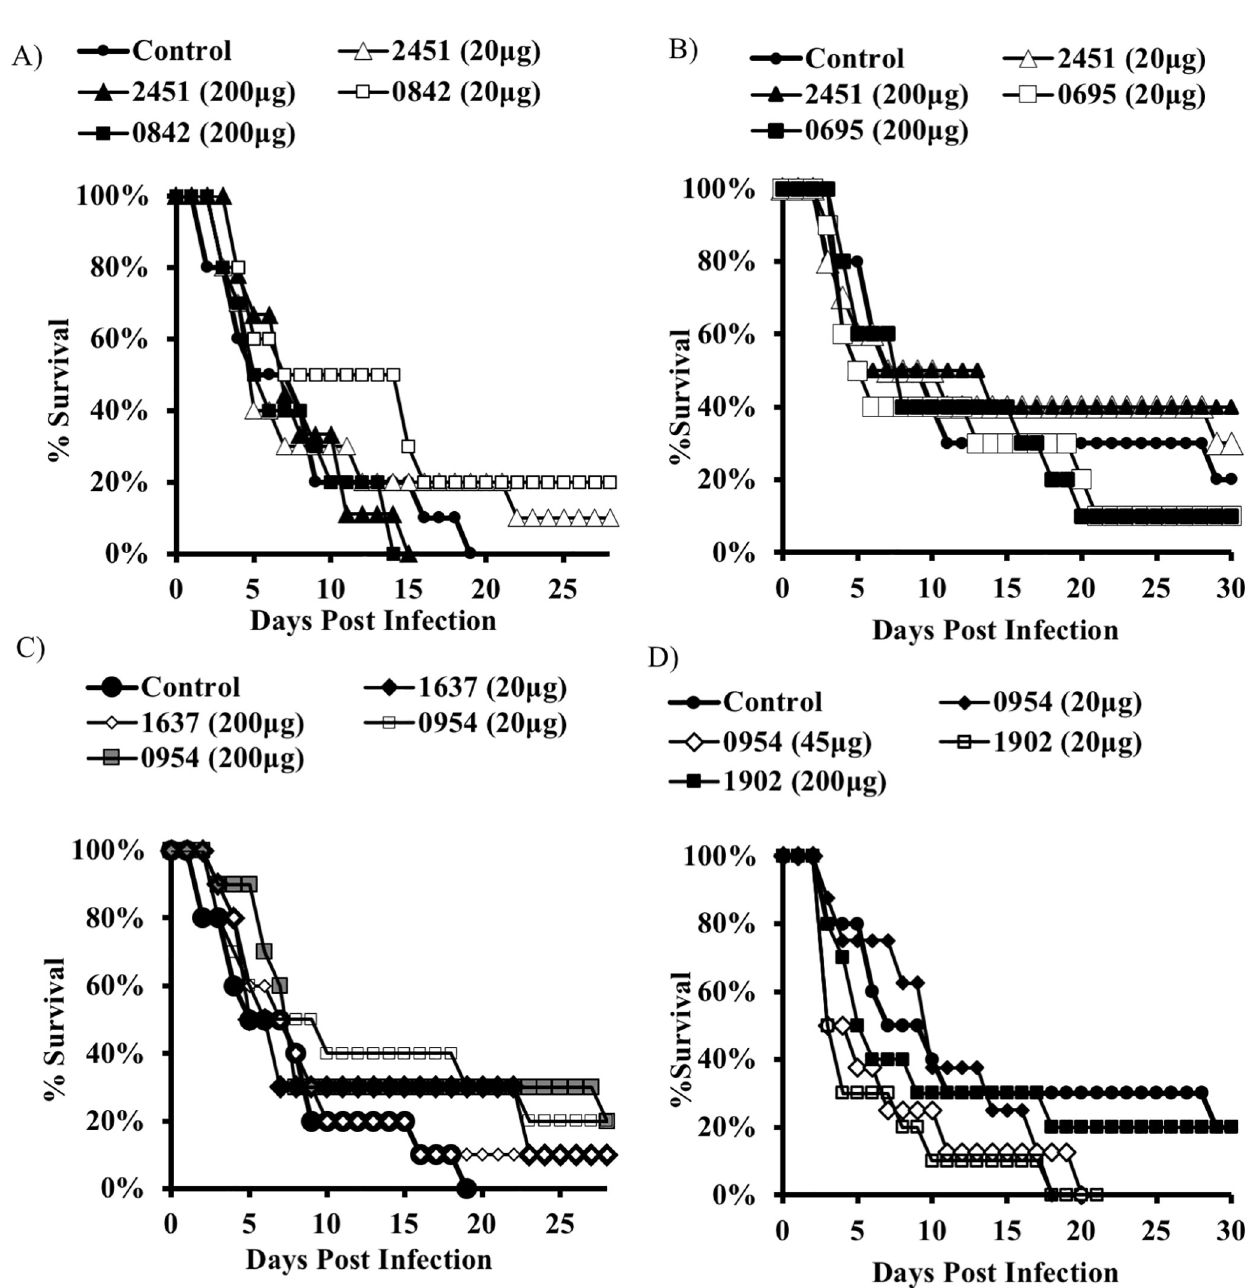
Fig 4. Dose optimization. A, B) Bacteremia model. BALB/c mice (n = 8) were immunized with individual antigens (20 or 200 micrograms) and then challenged with a S . aureus IV infection. Mice were monitored daily and euthanized when moribund. No benefit was observed in follow up studies in the bacteremia model. Increasing the antigen dose 10-fold did not result in a statistically significant benefit.